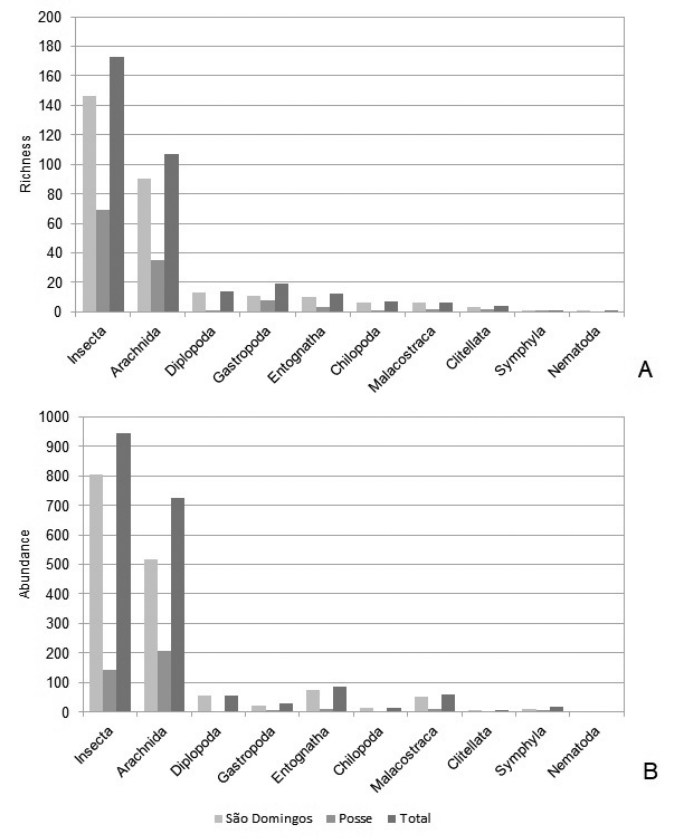
Figure 2. A Richness and B abundance of subterranean terrestrial invertebrate (by Class) from the São Domingos and Posse karst areas, state of Goiás, and from both regions